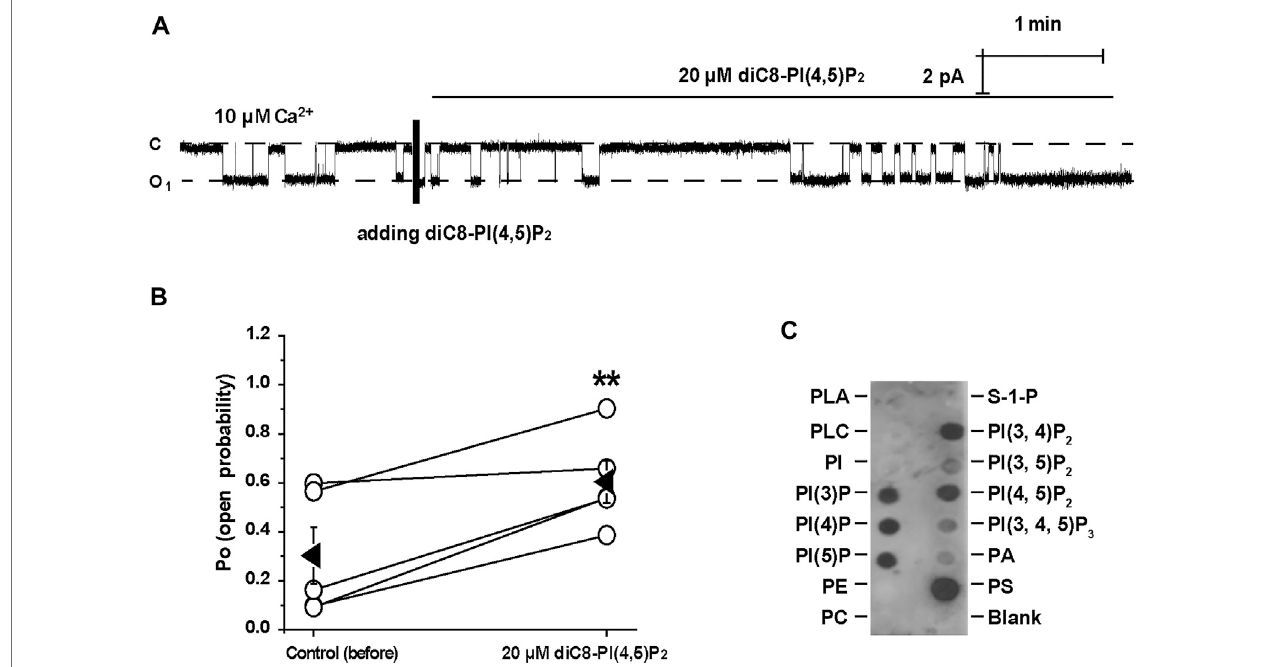
FIGURE 5 | PI(4, 5)P 2 stimulates TRPM4 via a physical interaction. (A) A representative single channel recording shows that diC8-PI(4,5)P 2 signi fi cantly increased TRPM4 activity. (B) Summary plots of TRPM4 channel P O under each indicated conditions. n (cid:2) 5 paired experiments. ** P < 0.01, signi fi cantly different with control. (C) TRPM4 was detected in dots where most anionic phospholipids including PI(4, 5)P 2 are located on PIP Strips membrane. Data represent three individual experiments showing consistent results.